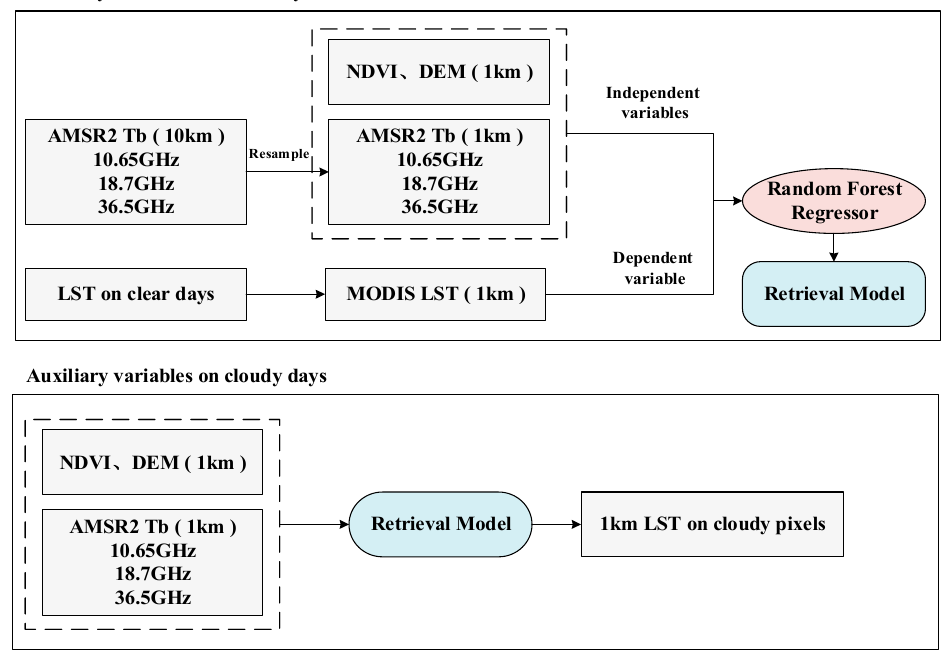
Figure 3. The importance ranking of different variables used in the random forest-based LST esti- mation.